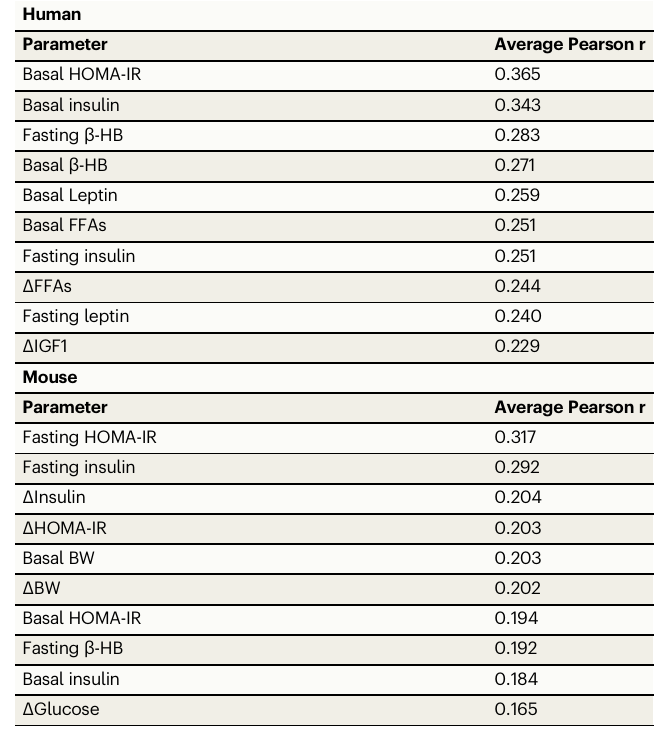
Table 3 | Absolute value of the average Pearson correlation r coef fi cients of the indicated parameters with the most robust biomarkers from humans and mice shown in Fig. 4c,